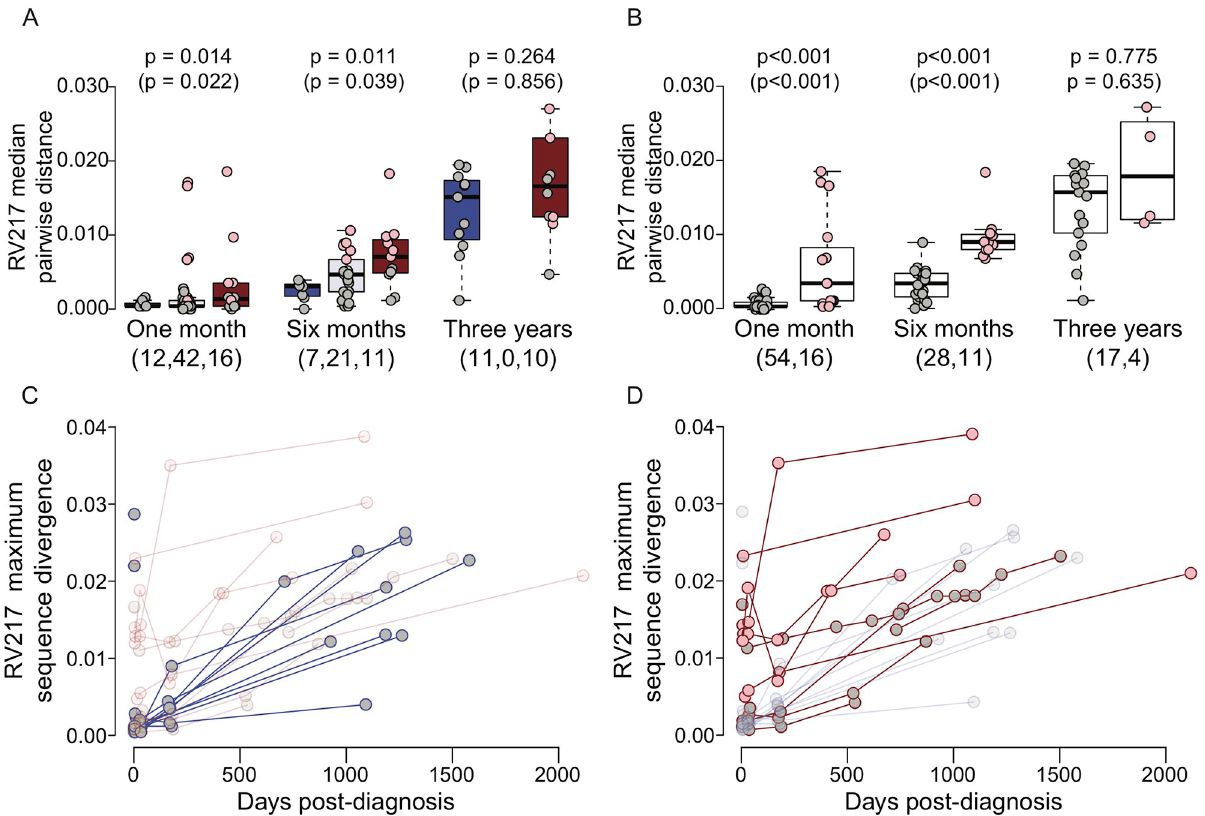
Fig 3. Higher diversity in infections with multiple founders in early infection. Comparisons of sequence diversity as a function of neutralization breadth and founder multiplicity in RV217 participants. Non-broad neutralizers (indicated in blue) are defined as individuals who neutralized < 35% of a 34-virus panel three to four years post-diagnosis and broad neutralizers (indicated in red) as individuals who neutralized > 70% of the panel. Individuals sampled less than two years post-infection (intermediate neutralizers) are also shown (indicated in lavender). Individuals with single founder infections are shown in grey and with multiple founder infections in pink. Median pairwise distance at one month, six months, and three years post-diagnosis in (A) non-broad, intermediate, and broad neutralizers and in (B) participants with single or multiple founder infections. The number of individuals in each group is shown in parenthesis and p-values for pairwise comparisons are shown above each pair. (C,D) Maximum sequence divergence over time from each participant’s consensus at the earliest sampling day for (C) non-broad neutralizers and (D) broad neutralizers. Circles indicate participants with single (grey) or multiple (pink) founder infections and lines indicate whether the individual achieved broad neutralization (red) or not (blue). A low-transparency representation of (D) is shown in (C) and vice versa. (A,B) P-values calculated after removing individuals identified as superinfected are shown in